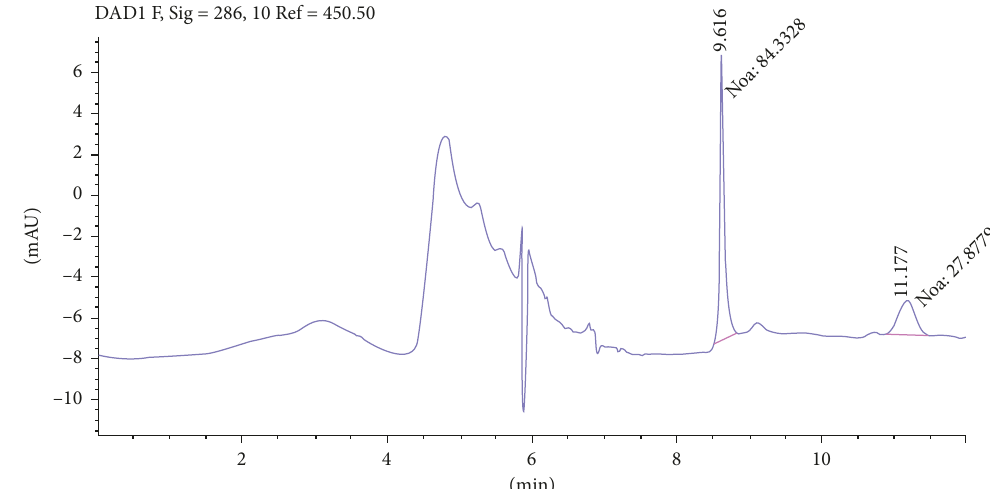
Figure 5: Fructose and sucrose peaks of the P1 sample, with fructose ( T